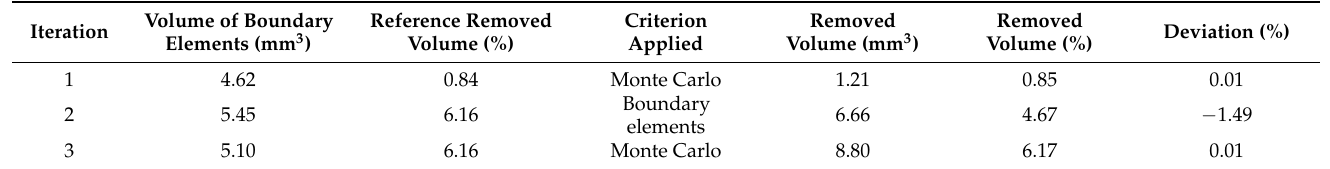
Table 3. Degradation results of the numerical method applied (PCL